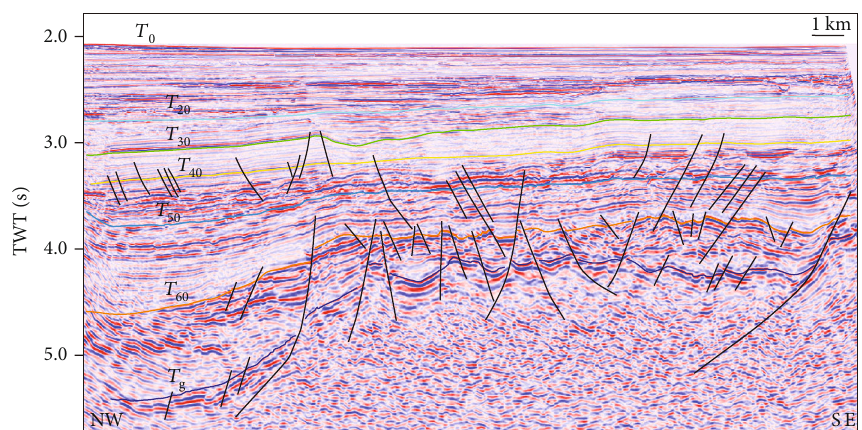
Figure 2: Sedimentary fi lling in the study area. The black lines indicate faults. The colorful solid lines represent seven seismic re fl ecting interfaces. Six sequences E-O (Eocene-Oligocene, T - T ), P (Pliocene, T Miocene, T 30 40